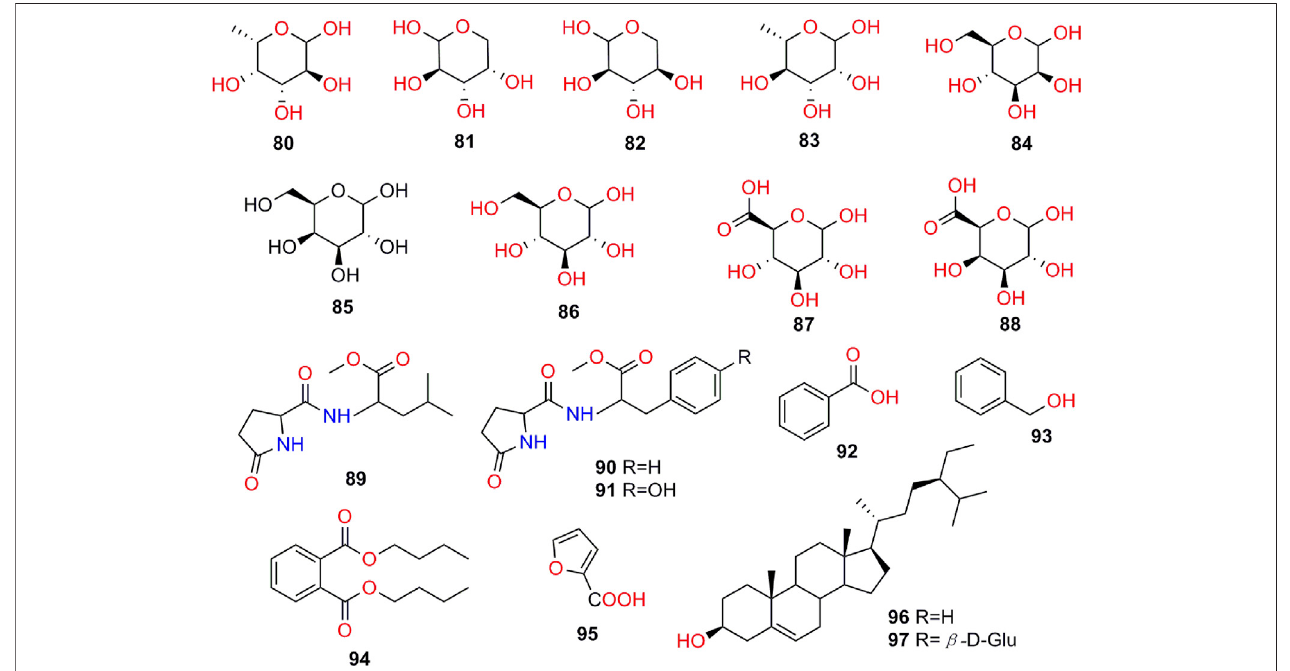
FIGURE 7 | Structures of polysaccharides and other compounds isolated from K. galanga